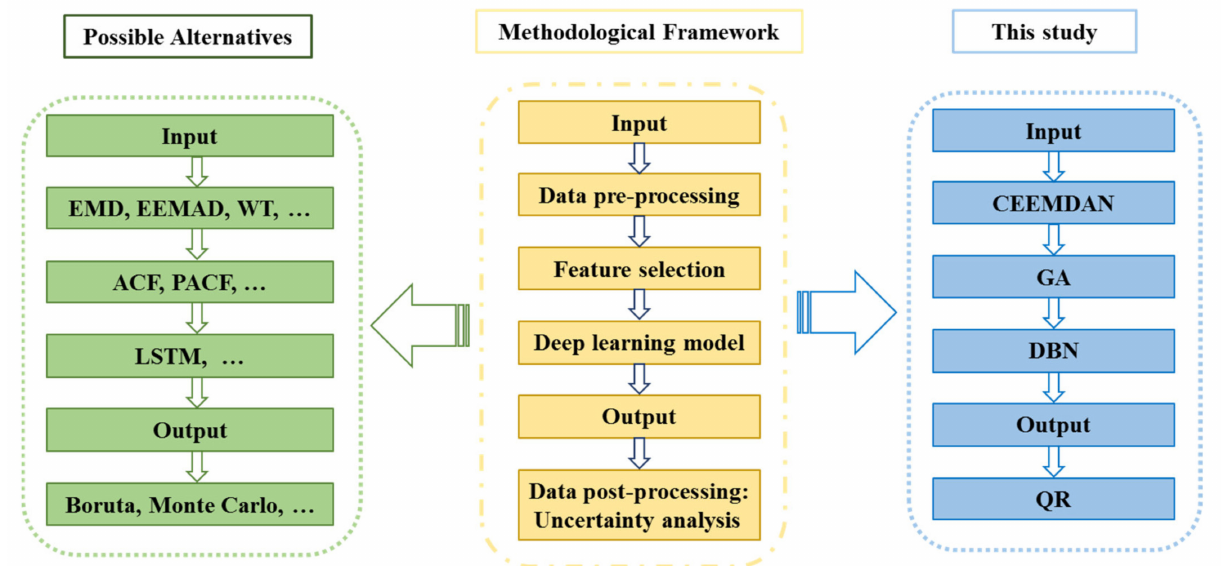
Figure 12. Proposed methodological framework and possible alternative